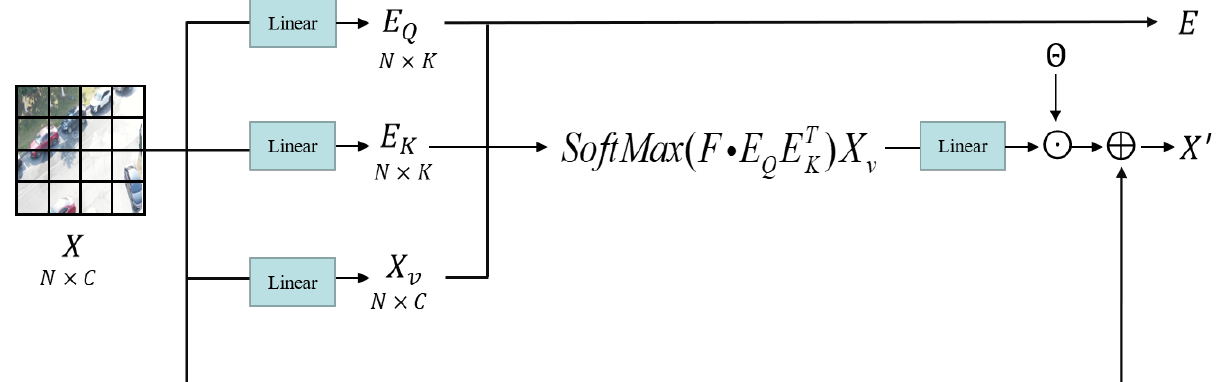
Figure 3. The detailed structure demonstration of FEAB.